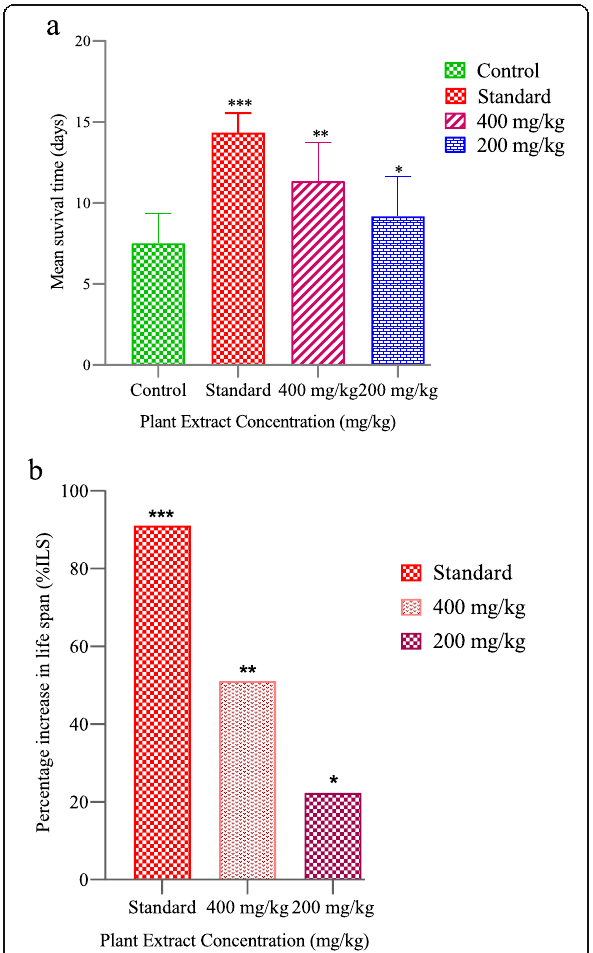
Fig. 4 a Mean survival time (days) of EAC cell bearing Swiss albino mice after 15 days treatment with Chenopodium album leaf extract. b Percentage increase in life span (% ILS) of EAC cell bearing Swiss albino mice after 15 days of treatment with Chenopodium album leaf extract